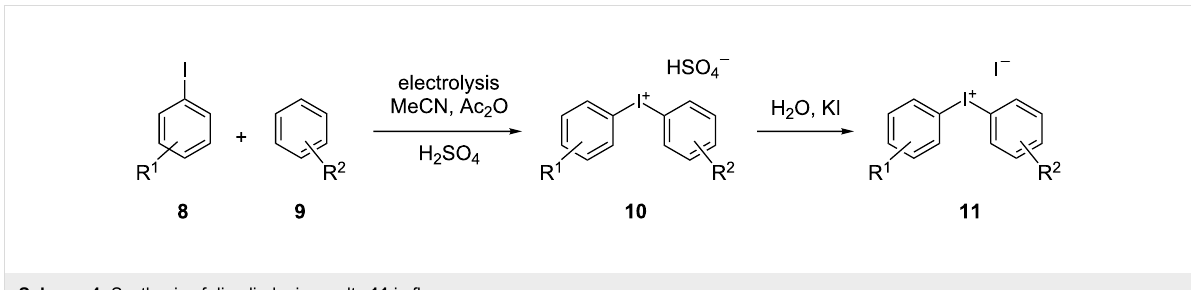
Scheme 4: Synthesis of diaryliodonium salts 11 in